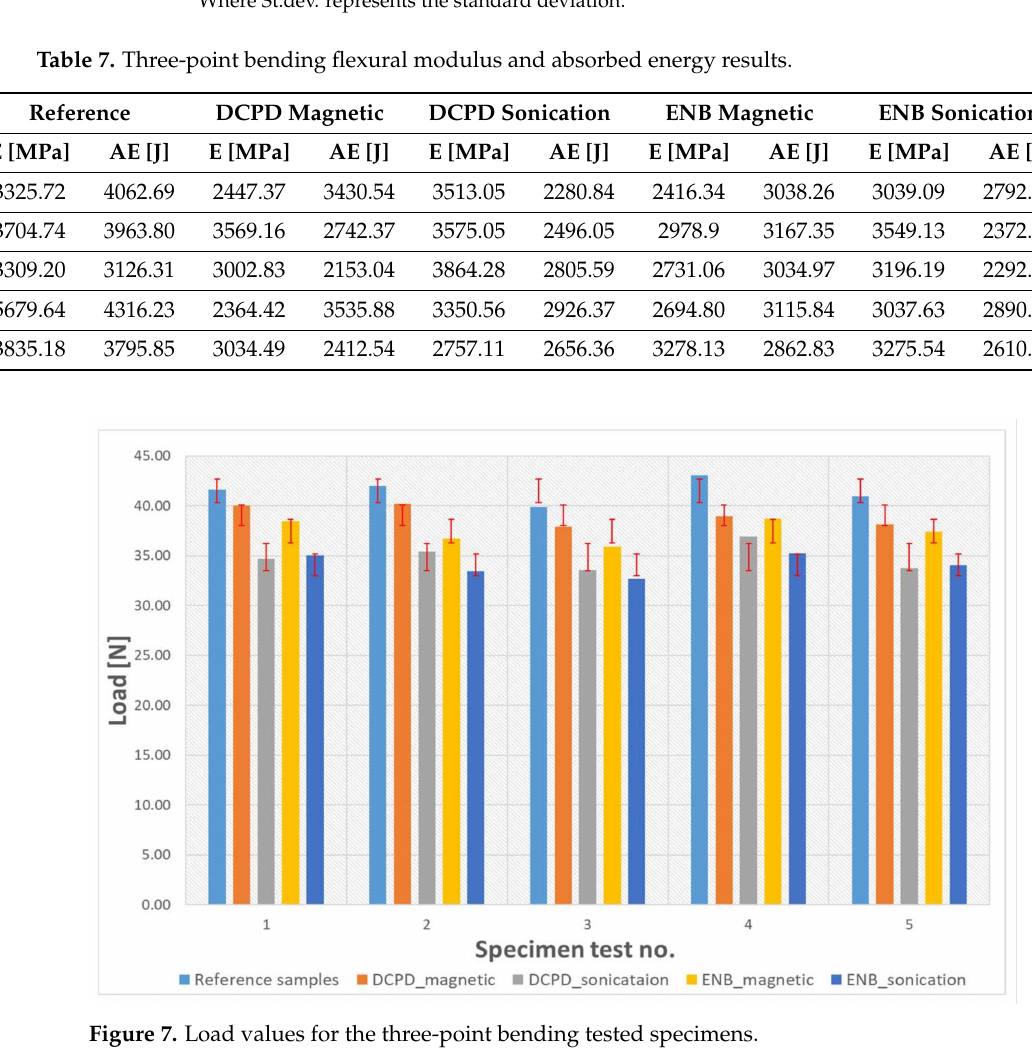
Figure 7. Load values for the three-point bending tested